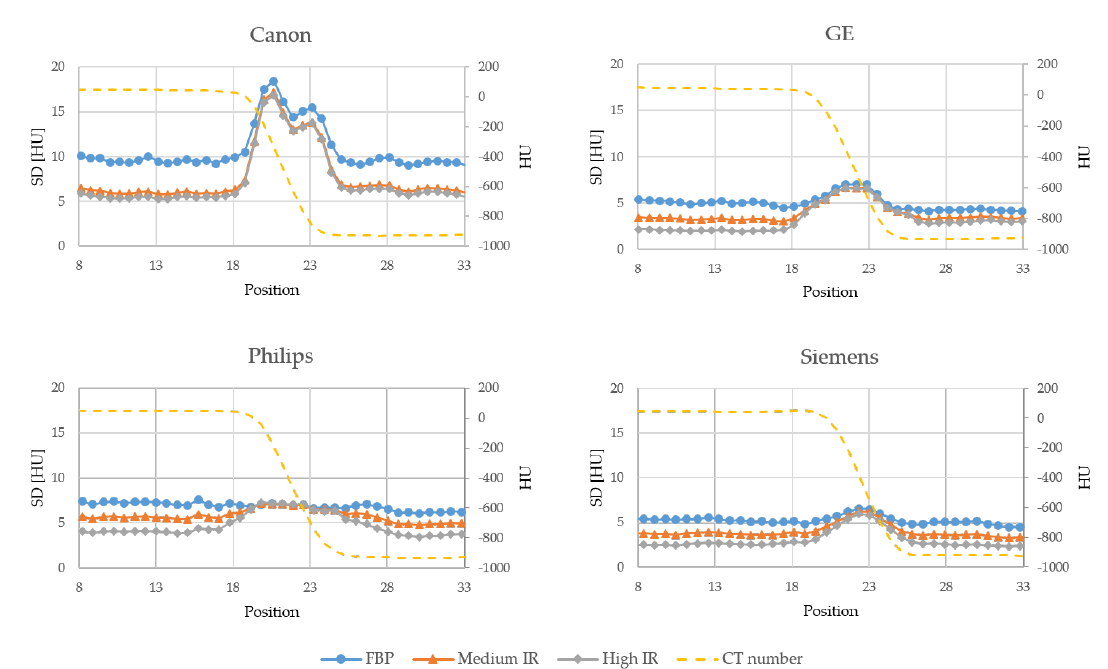
Figure 3. Edge profiles showing the standard deviation (SD) measured over the 1000 HU edge in the noise maps reconstructed with FBP, a medium level of IR and a high level of IR for each vendor. The dashed line shows the average CT number in the FBP images.